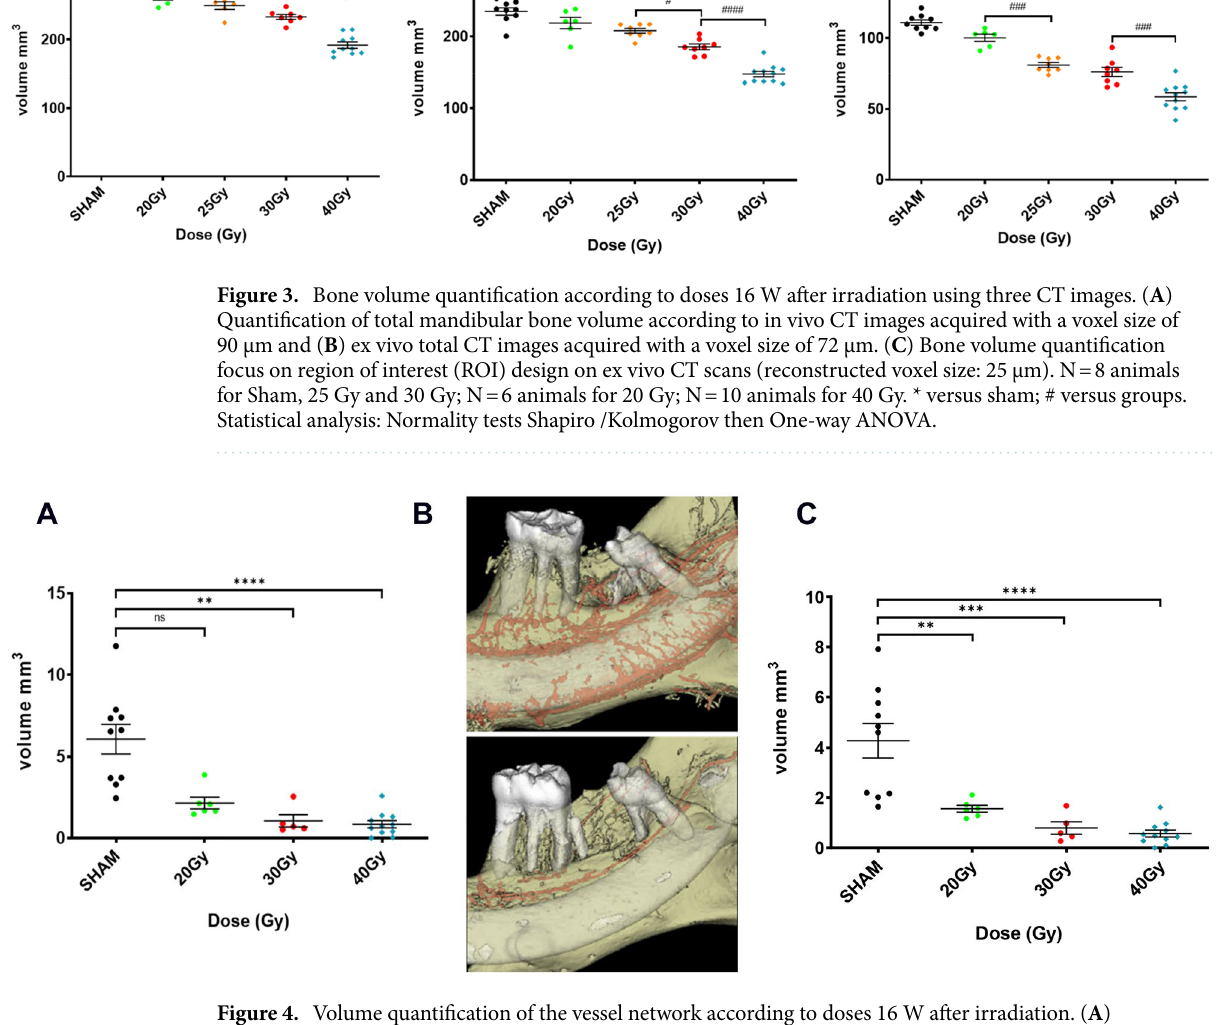
Figure 4. Volume quantification of the vessel network according to doses 16 W after irradiation. ( A ) Quantification of total mandibular vessel volume according to ex vivo CT images acquired with a voxel size of 72 µm. Statistical analysis: Kruskall Wallis non-parametric test. ( B ) Representative visualization of the vessel network (red) centered on ROI on ex vivo CT scans (72 µm) in sham (up) and irradiated 40 Gy (down). ( C ) Vessel volume quantification focused on ROI design on ex vivo total CT images acquired with a voxel size of 72 µm. Statistical analysis: Shapiro normality-test then One-way ANOVA. N = 10 animals for Sham, N = 6 animals for 20 Gy; N = 5 animals for 30 Gy and N = 11 animals for 40 Gy. * versus